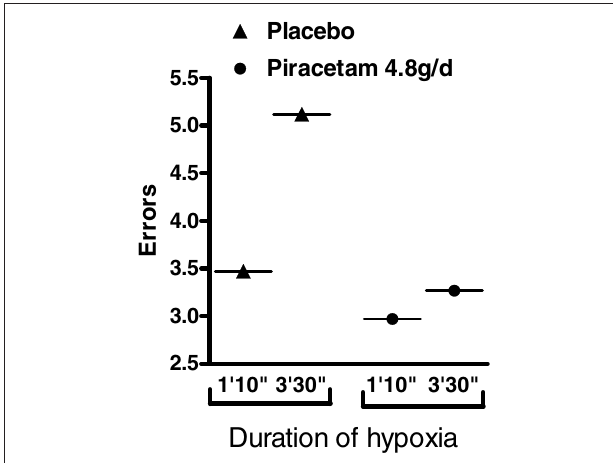
Figure 5 | Piracetam improves cognitive function in men after hypoxia. The ability of 12 healthy volunteers to concentrate in a low oxygen pressure tank was assessed by measuring errors in a visual attention test in a placebo-controlled crossover trial in which volunteers were given 4.8 g piracetam daily for 4 days and 7.2 g on the fifth day. Depending on the time of hypoxia, errors were observed. Error number was significantly reduced by piracetam treatment, especially for the longer hypoxic period. Data are modified from Demay and Bande